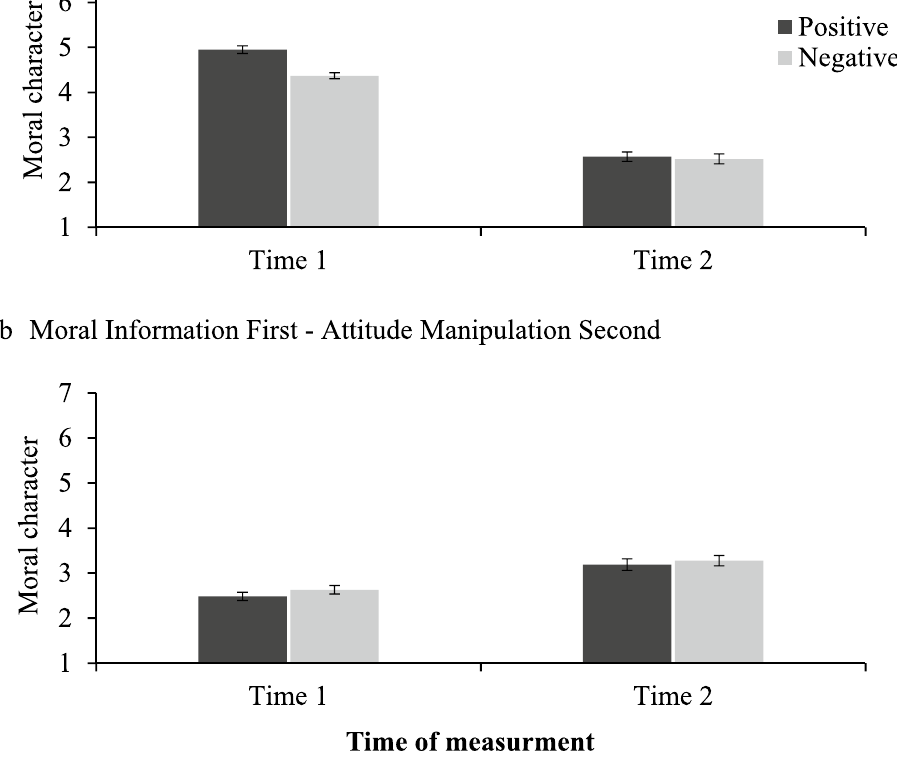
Figure 3. Mean moral character judgments at Time 1 and Time 2 as a function of the sequence and attitude manipulation. Higher scores indicate more positive judgments of moral character. The error bars represent one standard